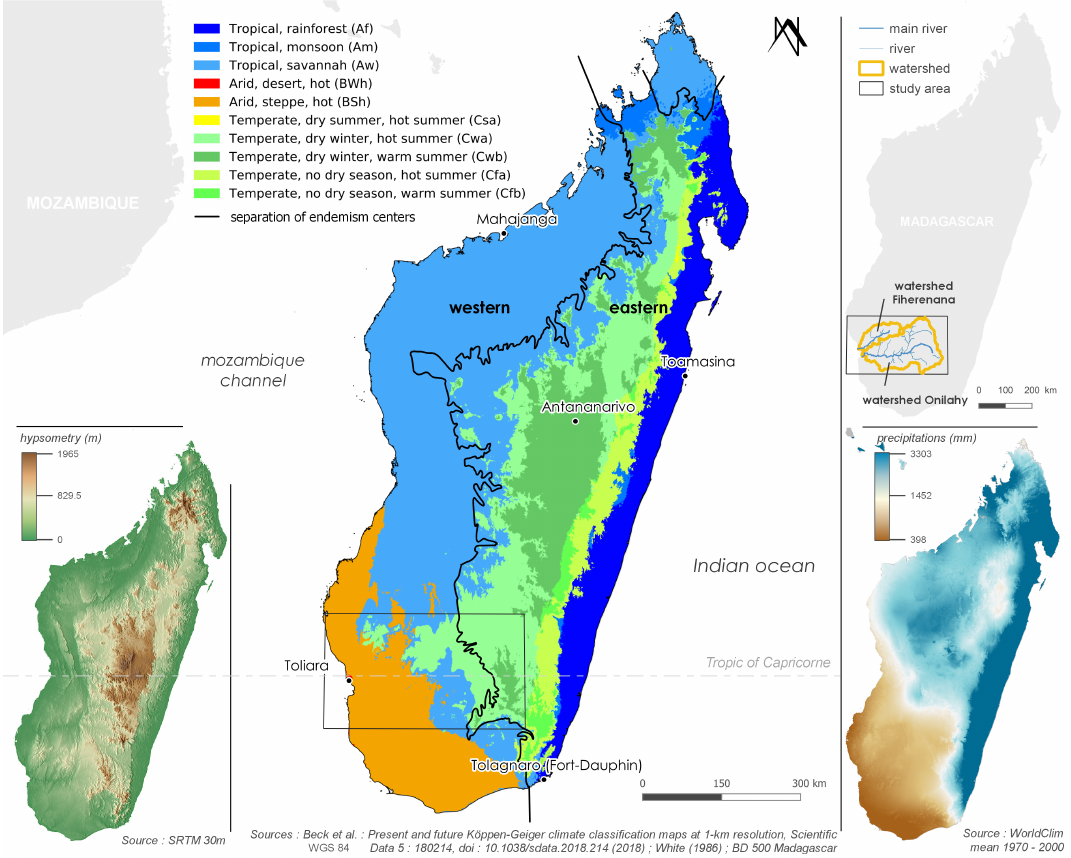
Figure 2. Fire predisposition factor, the climate. Center : From the Köppen-Geiger climate classi- fication map for Madagascar (1980–2016) and limit centers of endemism from White (1986). Left : Hypsometry from SRTM 30 m. Top- right : location of watersheds in southwestern Madagascar. Bottom- right : Mean rainfall in mm per year between 1970 and